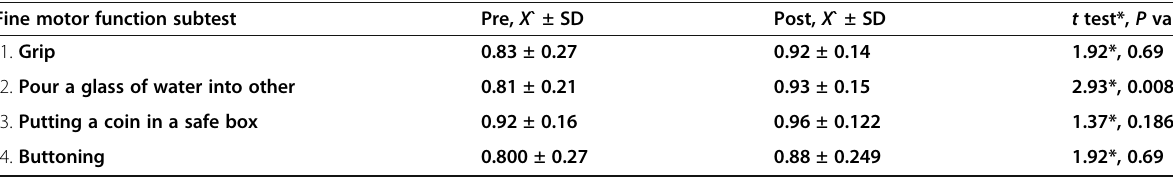
Table 5 Comparison of total mean scores between the pre-training and post-training results regarding the fine motor function subtest in the dysgraphia disability scale ( N , 20 cases) (done by paired sample t test) Fine motor function